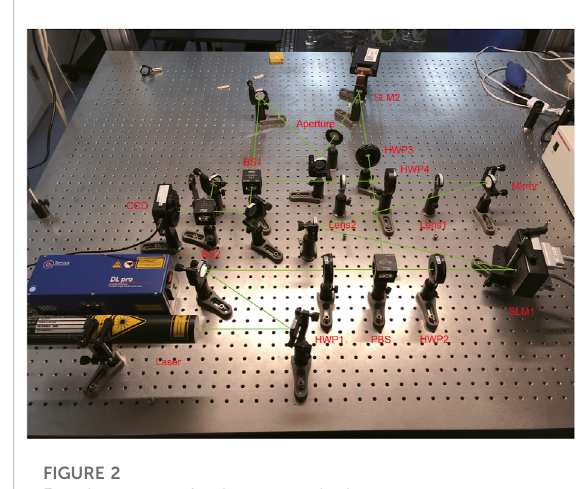
FIGURE 2 Experiment setup for the proposed